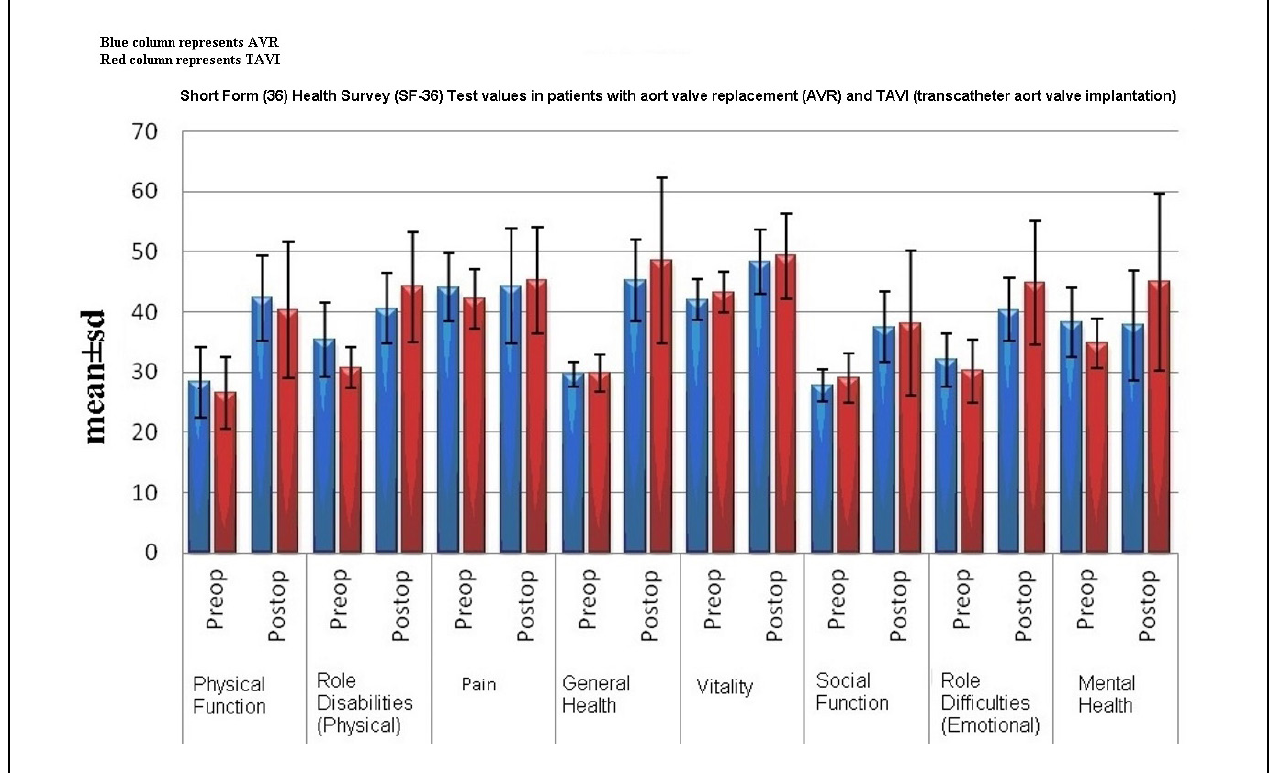
Fig. 1 - Short Form (36) Health Survey (SF-36) Test values in patients with aortic valve replacement (AVR) and TAVI (transcatheter aortic valve implantation); blue column represents AVR, red column represents